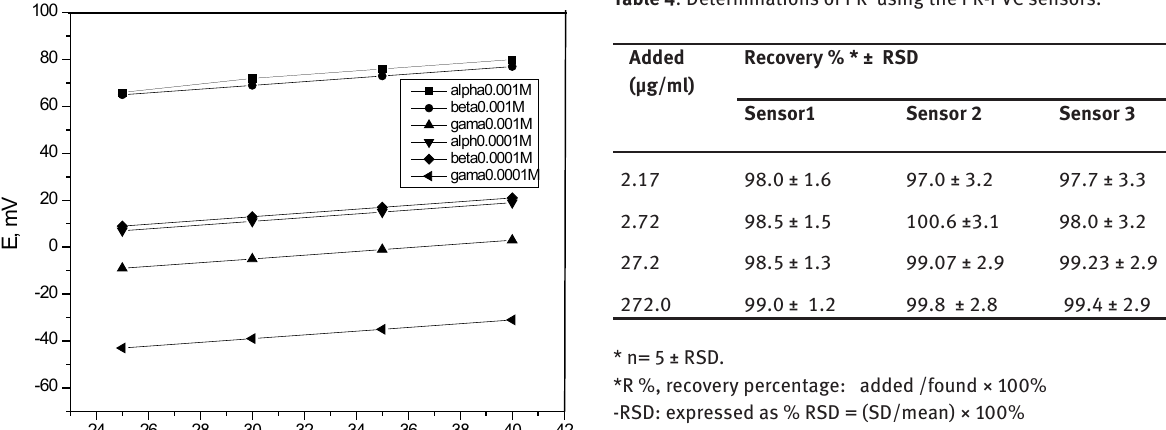
Table 4 : Determinations of PR using the PR-PVC